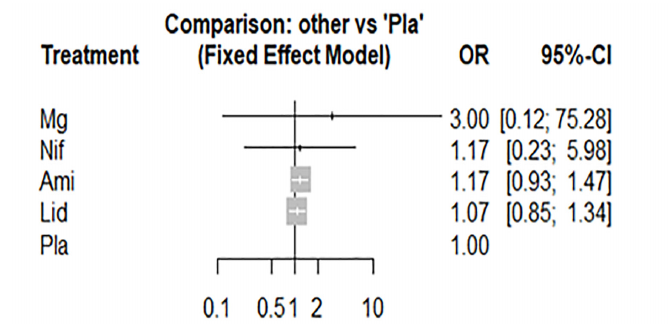
Figure 6. The forest plot of the network meta-analysis comparing the odds ratio of survival with good neurological outcomes among the pharmaceutical